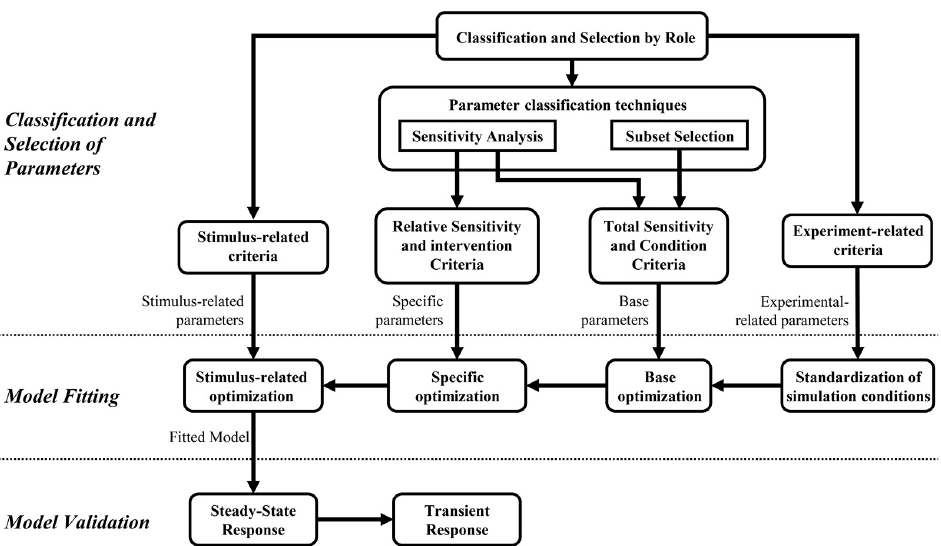
Figure 1. Schematic diagram of the fitting and validation strategy. The dotted lines divide the diagram into the main procedures and their respective stages: the first procedure is at the top and corresponds to the classification and selection of parameters; the second is in the middle and corresponds to model fitting, and the third one is at the bottom and corresponds to model validation.